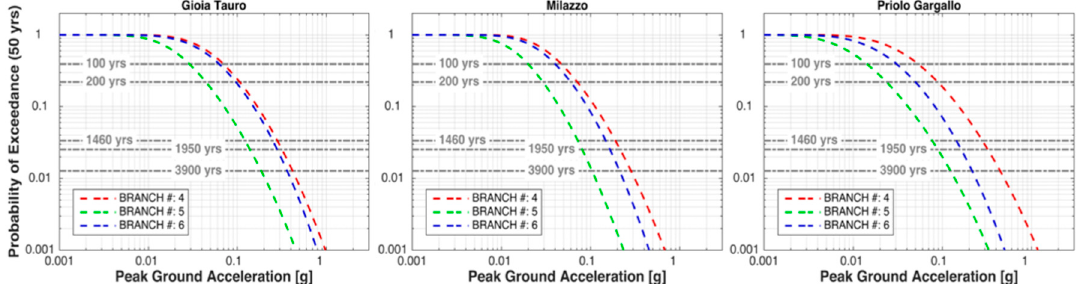
Figure 28. Probability of exceedance (50 years) for the three sites of interest, calculated for the PGA considering the logic tree branches related to the A1MPS16 node (see Figure 22).